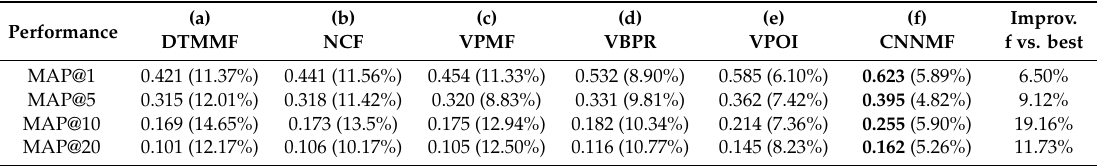
Table 5. The performance with 5% cold start travel locations in terms of MAP@n. (The numbers inside parentheses indicate the performance reductions compared to the performance without location cold start, as shown in Table